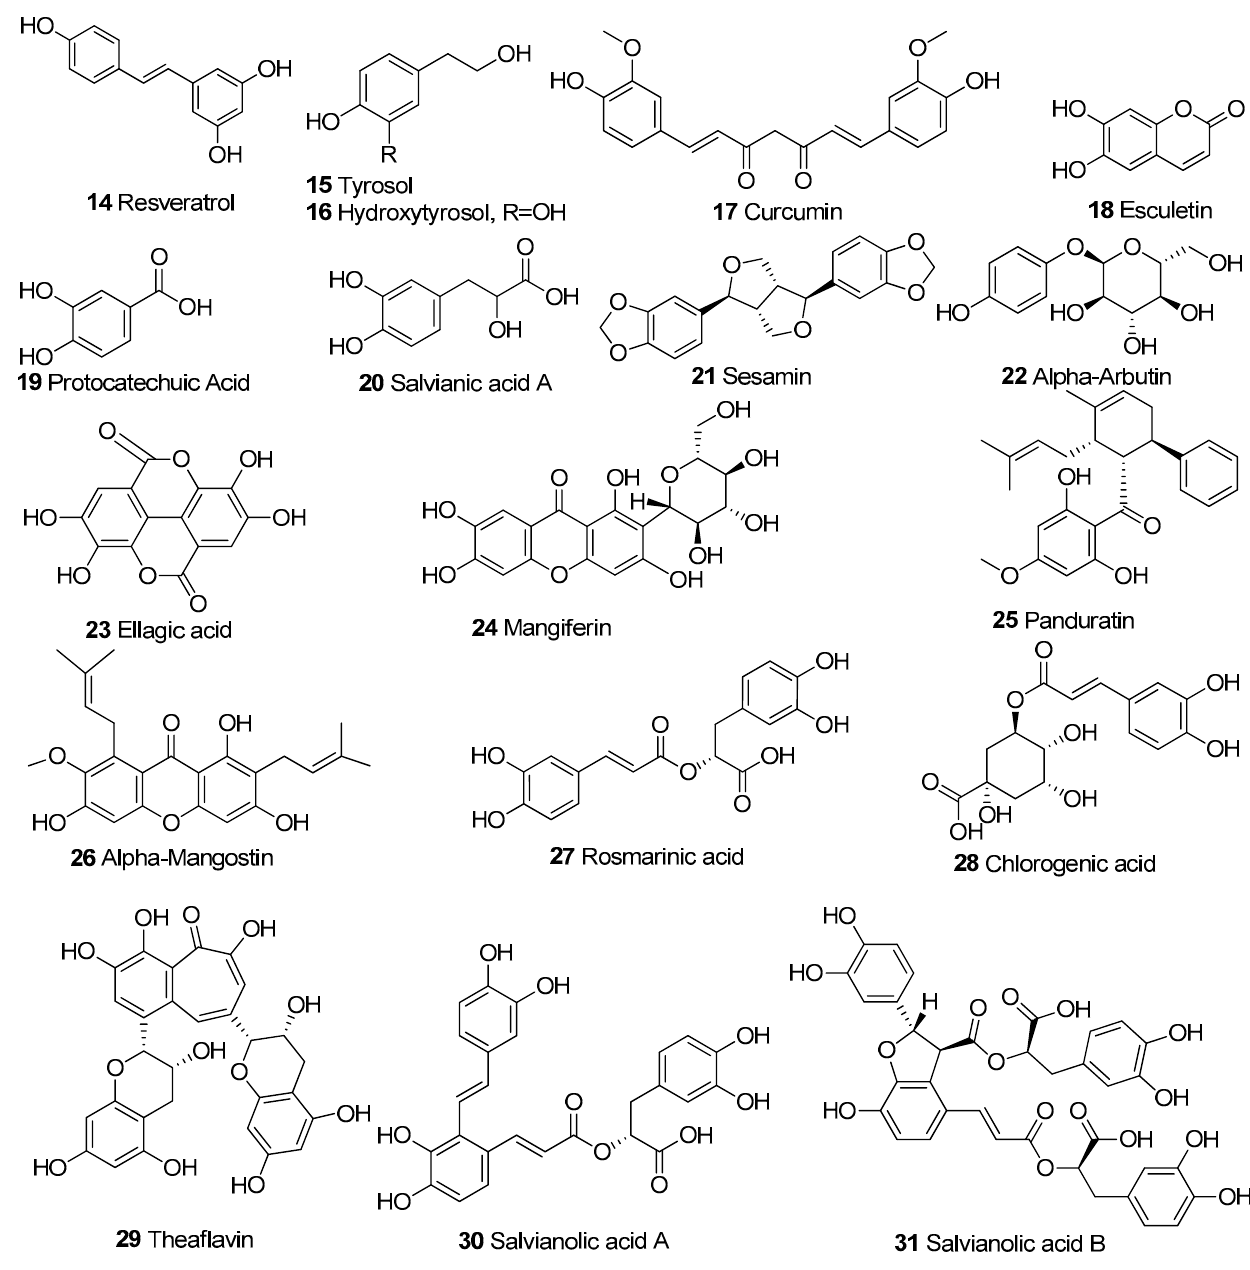
Figure 4. Chemical structures of other phenolic compounds apart from flavonoids.